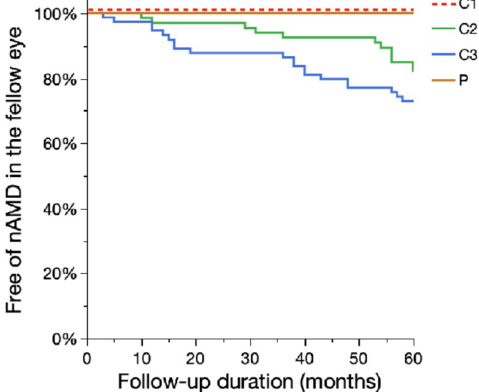
Fig 4. Kaplan Meier curve for nAMD-free periods in each category. The occurrence of nAMD in the fellow eye was used as an endpoint. P < 0.0001. Log-rank test.